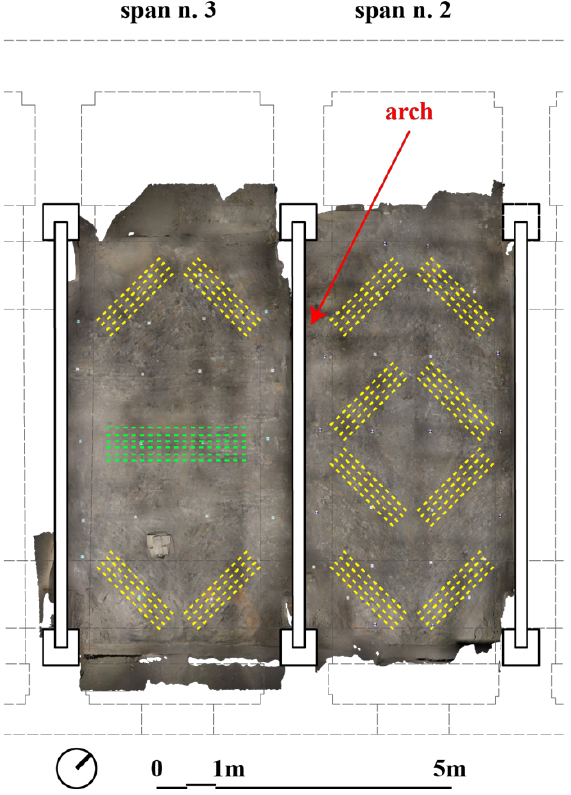
Figure 7. The Italian Cultural Institute complex with the chapel Figure 9. The orthomosaic of the extrados spans no. 2 and no. 3. on the south-west side (courtesy of the Italian Cultural The same shape at the intrados corresponds to two different Institute). construction techniques: bricks arrange linear to the wall (green) and diagonal (yellow) The arches with the brackets visible at the intrados help the construction of the vault by splitting the space to be